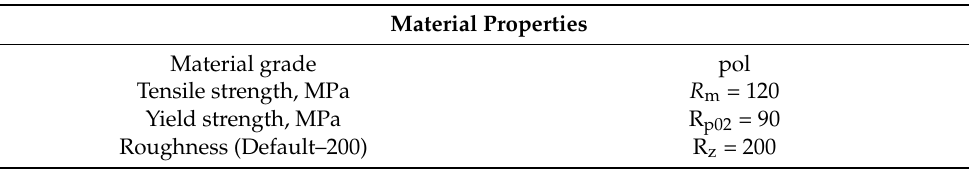
Table 3. The main mechanical parameters (compositions No. 15, 23).